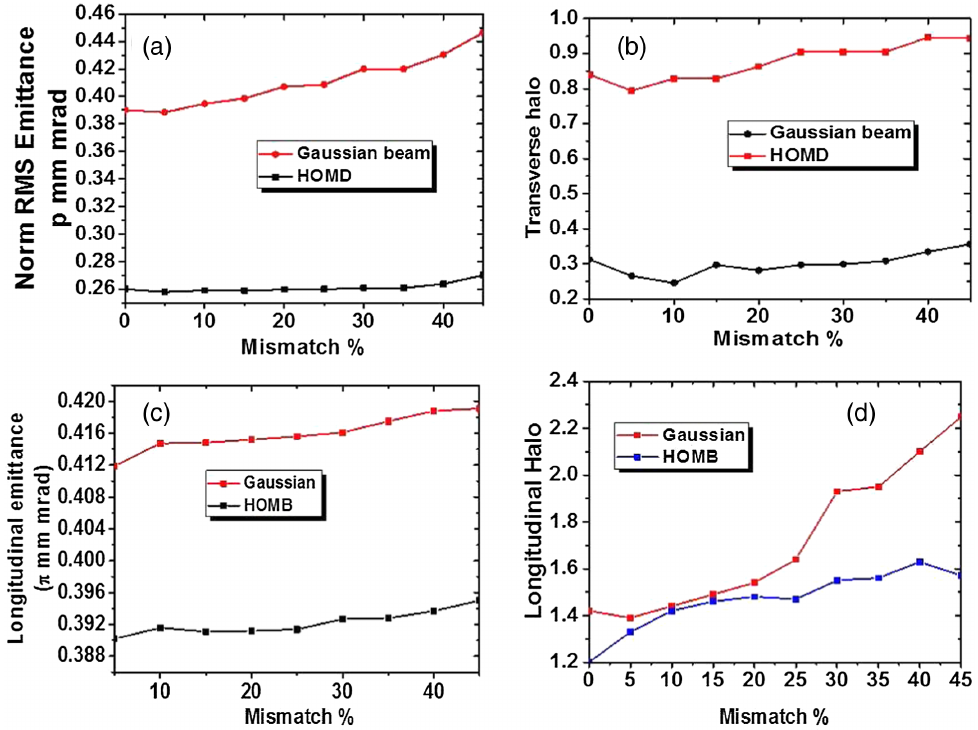
FIG. 7. For the Gaussian and HOMB distributions, variation as a function of initial beam mismatch of, (a) transverse emittance, (b) transverse halo parameter, (c) longitudinal emittance, and (d) longitudinal halo parameter, all calculated at the exit of the RFQ.